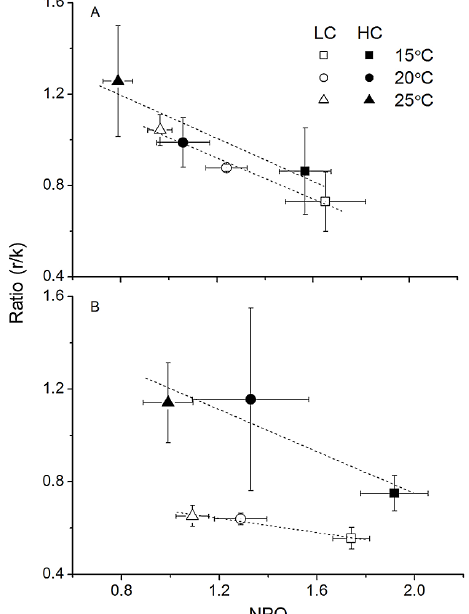
Fig. 4. Ratio of damage ( k ) to repair ( r ) as a function of non- photochemical quenching (NPQ) of P. tricornutum cells grown at ambient (LC, white symbols) and elevated CO 2 (HC, black symbols) concentrations when exposed to PAR+UV-A (A) or PAR+UV-A+UV-B (B) at 15 (squares), 20 (circles) or 25 ◦ C (tri- angles). The broken lines represents linear regressions ( A : R 2 = 0 . 86(LC) and 0.98(HC); B : R 2 = 0 . 85(LC) and